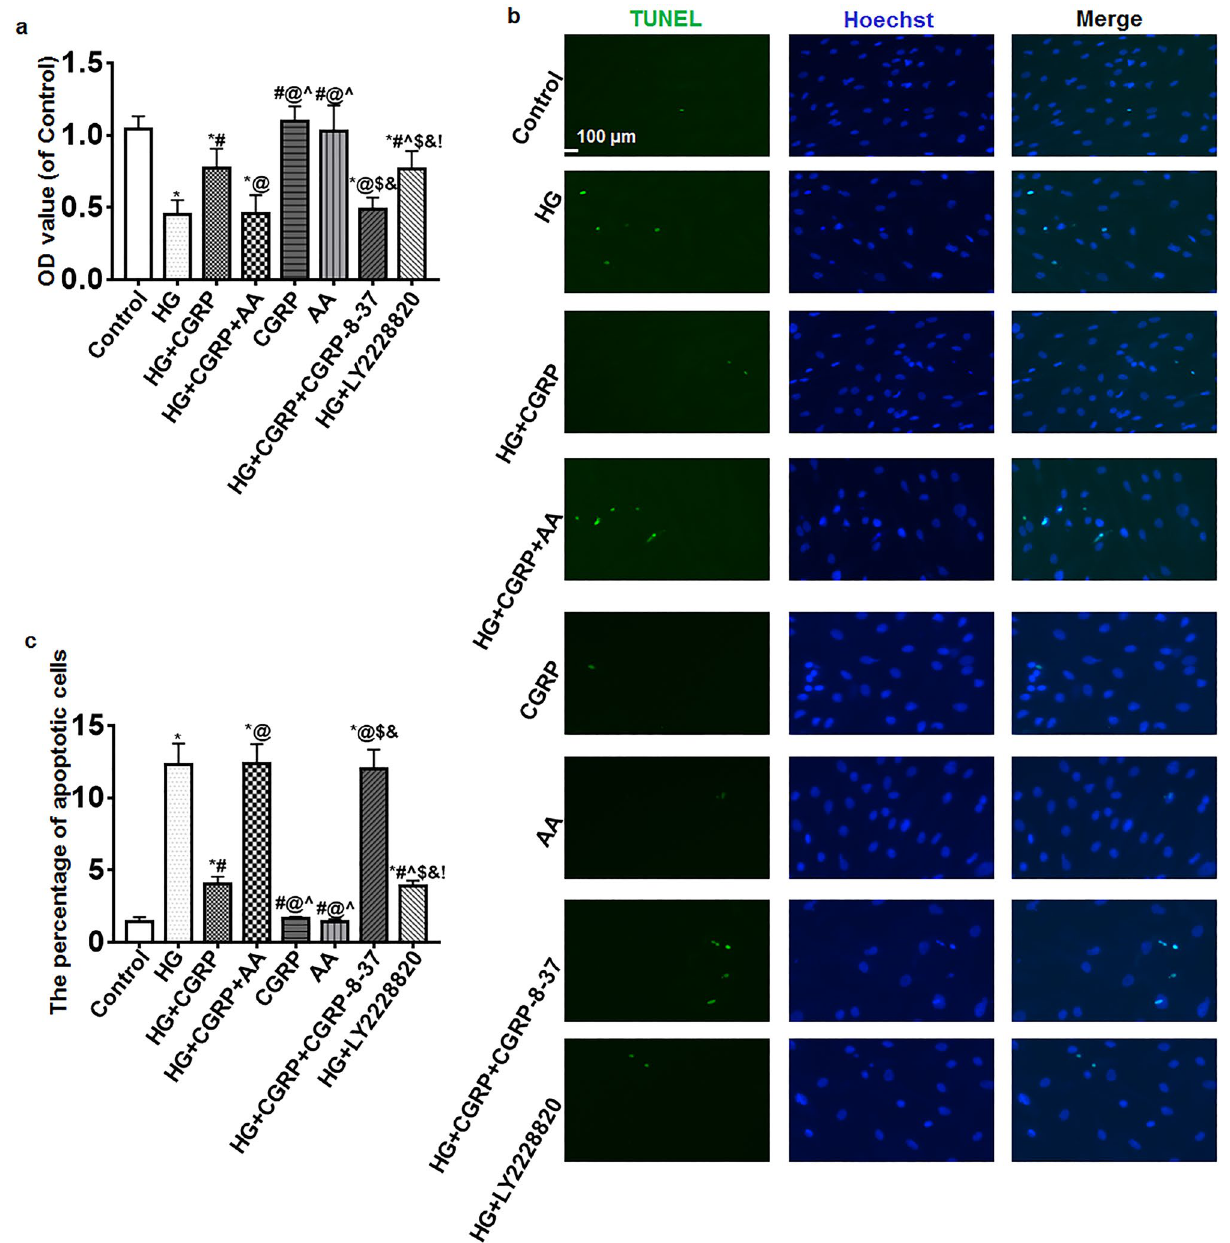
Figure 1. ( a ) The viability of BSMCs was detected by MTT. Compared with the control, CGRP and AA groups, the OD values of the other groups decreased but the OD values of the HG + CGRP and HG + LY2228820 groups were higher than that in the HG, HG + CGRP + AA and HG + CGRP + CGRP-8-37 groups. ( b ) TUNEL assay results showed that there were almost no apoptotic cells in the control, CGRP and AA groups. More apoptotic cells were observed in the HGgroup, after CGRP or LY2228820 treatment, the number of apoptotic cells was decreased. AA or CGRP-8-37 reversed the effect of CGRP on the cells. ( c ) Statistical histogram of the percentage of apoptotic cells in each group. *VS. control group, p < 0.05; # VS. HG group, p < 0.05; @ VS. HG + CGRP group, p < 0.05; ^ VS. HG + CGRP + AA group, p < 0.05; $ VS. CGRP group, p < 0.05; & VS. AA group, p < 0.05; ! VS. HG + CGRP + CGRP-8-37 group, p < 0.05. Bar = 100 μm. n = 6. The bar charts were created by GraghPad Prism 7.0 software (Version 7.00, URL: www. graph pad. protein bands were visualized using Odyssey laser scanning system (LI-COR Inc., USA) and the intensities were quantified by Odyssey 3.0 image analysis system software. Statistical analysis. Data were expressed as mean ± standard deviation (M ± SD). The statistics package for social science 21.0 (SPSS 21.0) was used to do the statistical analysis. The differences among the groups were ana-